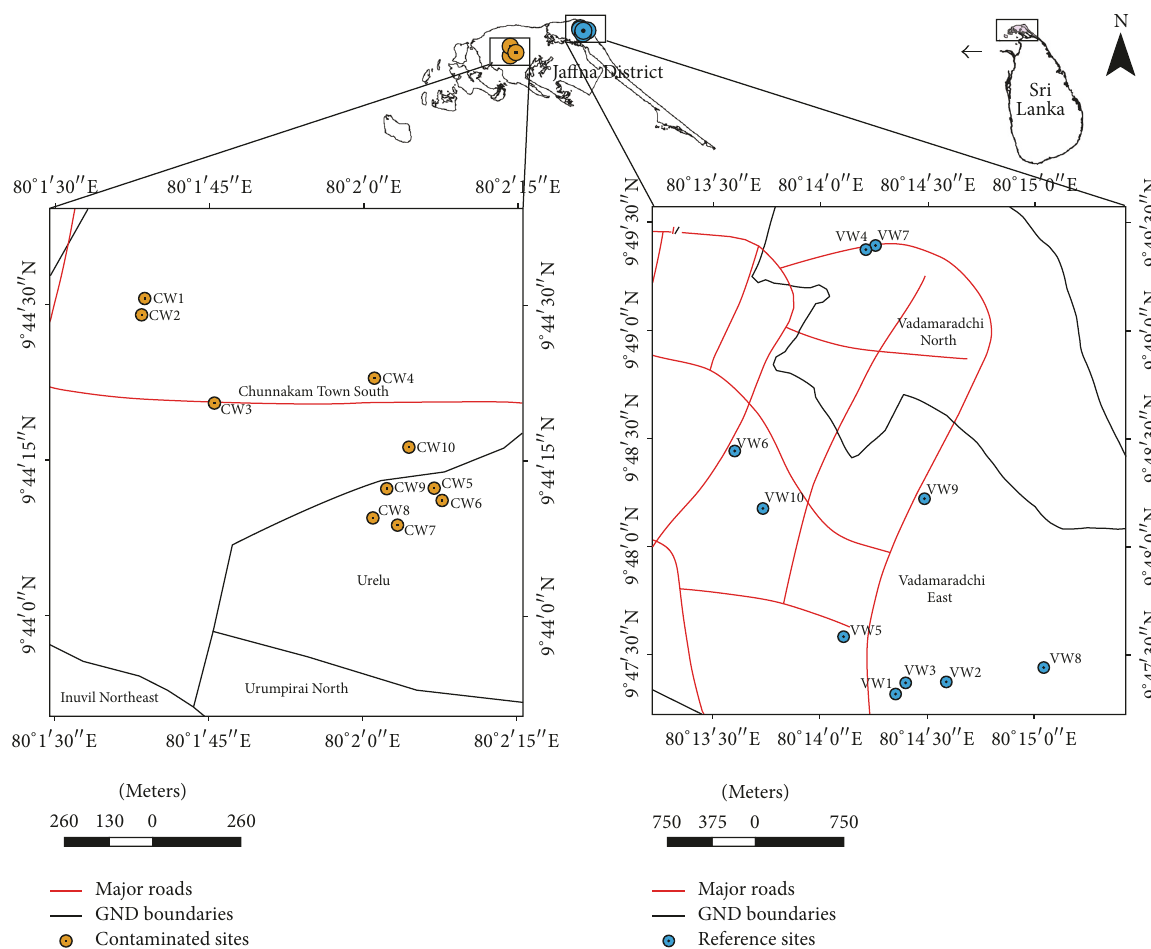
Figure 1: Map of the study area showing the sampled wells. (CW: wells in the Chunnakam area; VW: wells in the Vadamaradchi